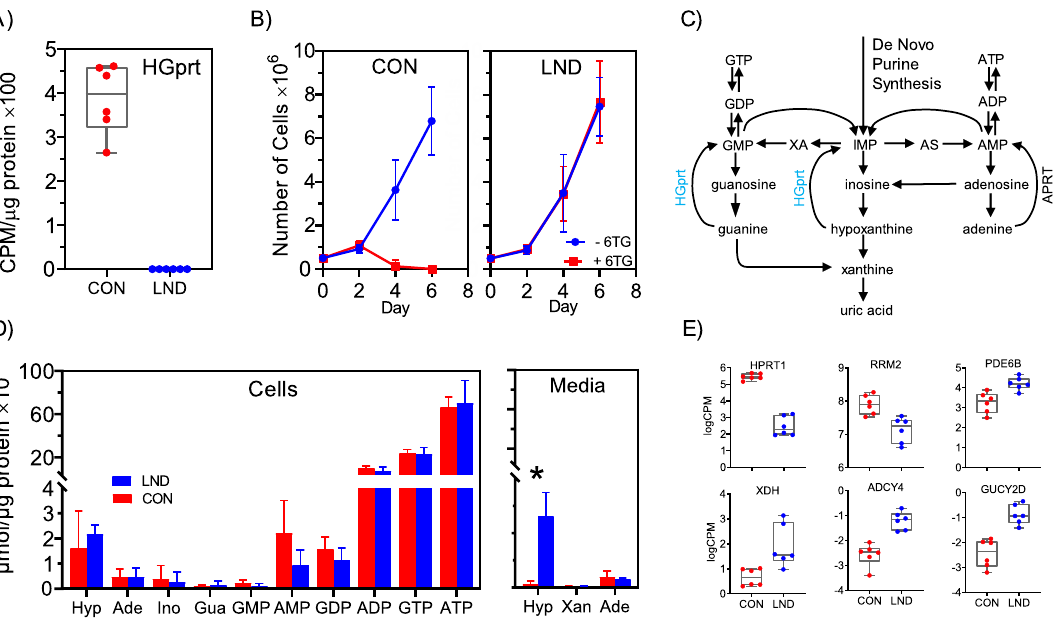
Figure 5. Functional assessment of HGprt deficiency. All control iPSC lines (red, n = 6) demonstrated readily detectable activity in the HGprt enzyme assay, while all LND iPSC lines (blue, n = 6) had no detectable activity ( A ). Results are shown as box plots with results for each line shown separately. There was no obvious difference in the growth of the control and LND lines in the absence of 6TG (blue lines, B ). However, the control lines showed a clear toxic effect of 6TG, while the LND lines appeared to be resistant to it (red lines, B ). In these growth curves, the error bars show the standard deviation. HGprt plays an important role in the metabolism of hypoxanthine ( C ), leading to marked hypoxanthine accumulation that is released into the tissue culture medium; with no apparent impact on intracellular purines ( D ). In this panel, controls are shown in red and LND in blue, with error bars reflecting standard deviations. Among 109 genes in the KEGG pathway for purine metabolism, only 6 were significantly different between control (red) and LND (blue) iPSC lines at FDR < 0.05 ( E